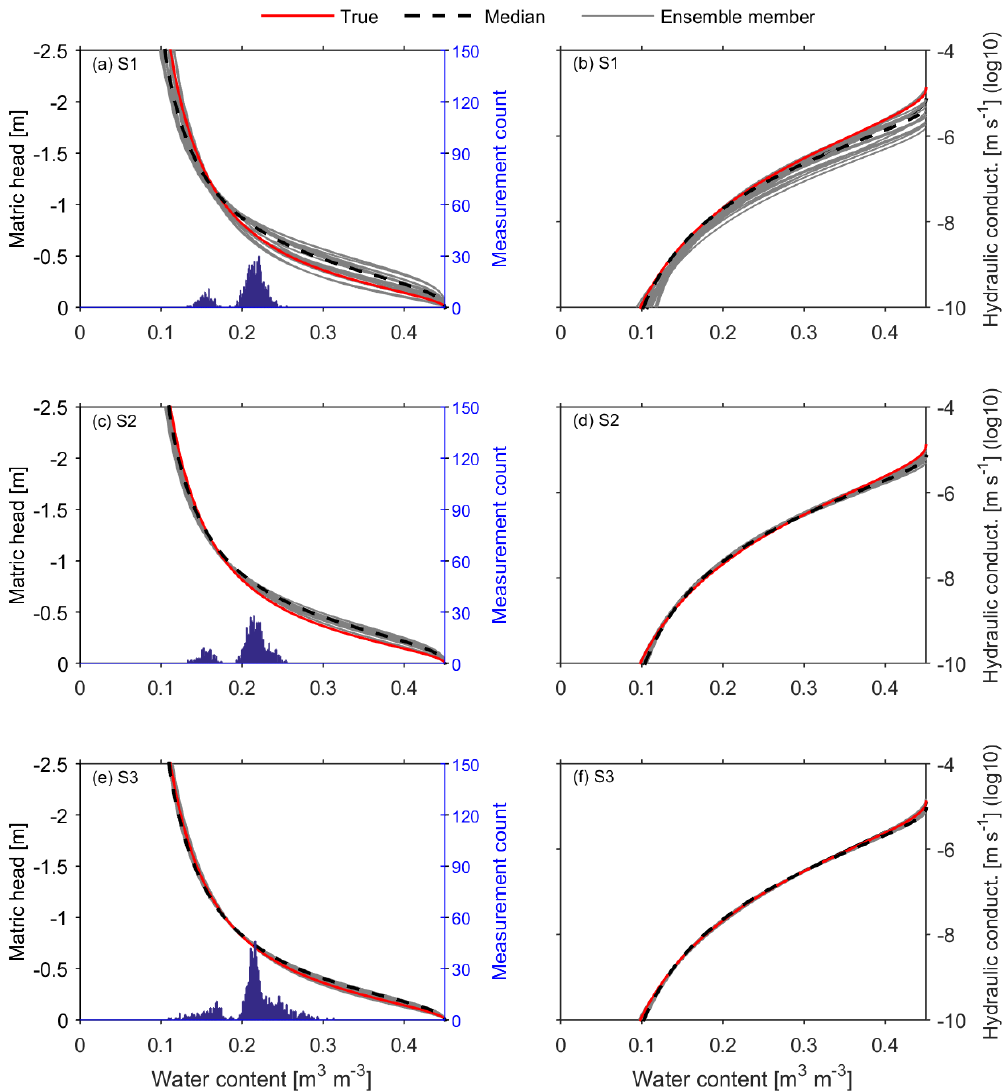
Figure 8. The same as Fig. 7, but using wider soil water content range by adding one more GPR measurement before the rainfall (black dot in Fig. 3a). Excellent performances of the approach are achieved in S2 and S3, while only a little improvement happens in S1 compared to Fig. 7. Apart from the soil water content range, the slope-induced lateral water redistribution is also essential to the proposed